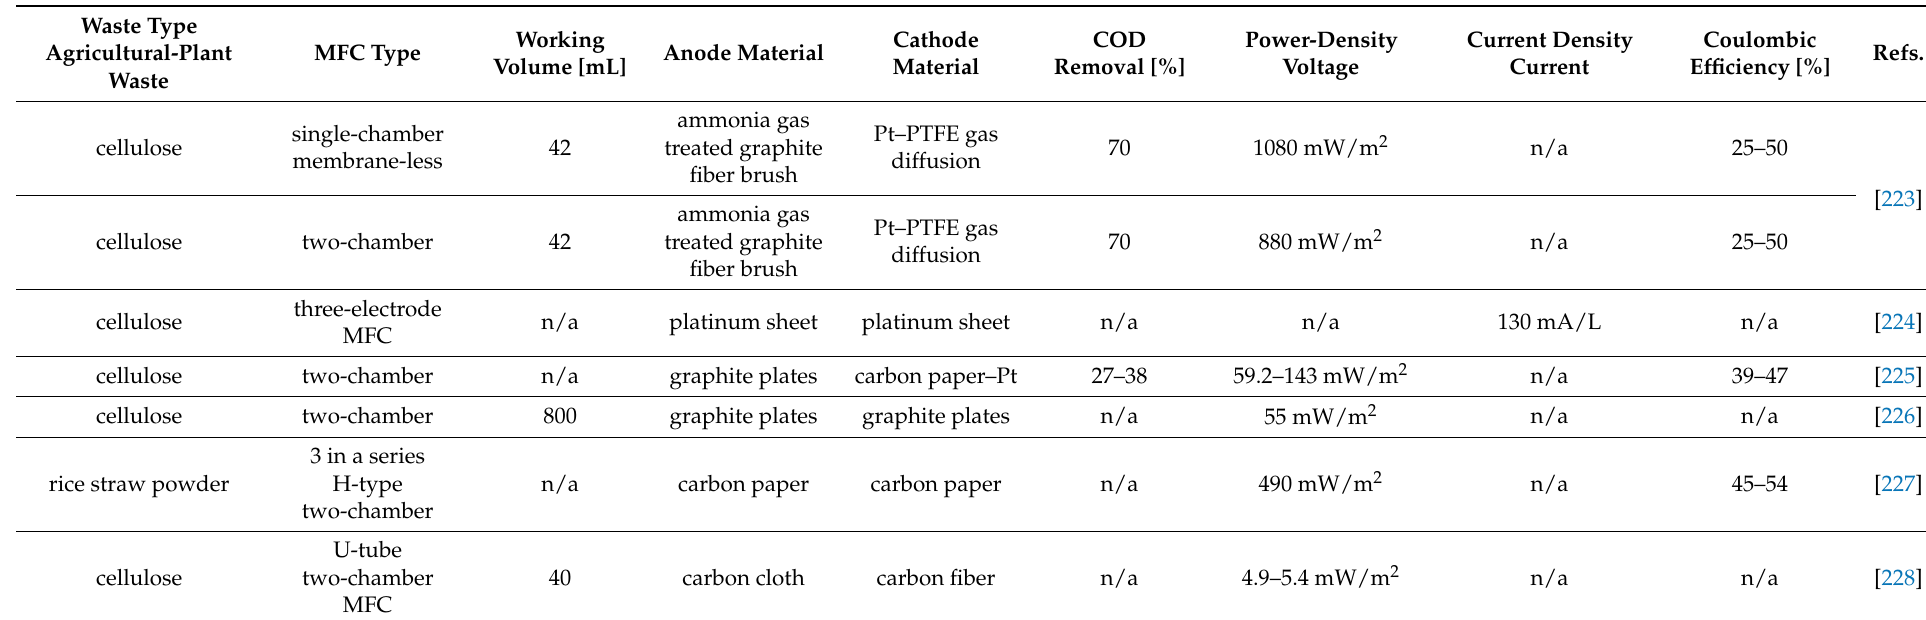
Table A8. Summary of studies reporting use agricultural and plant waste in